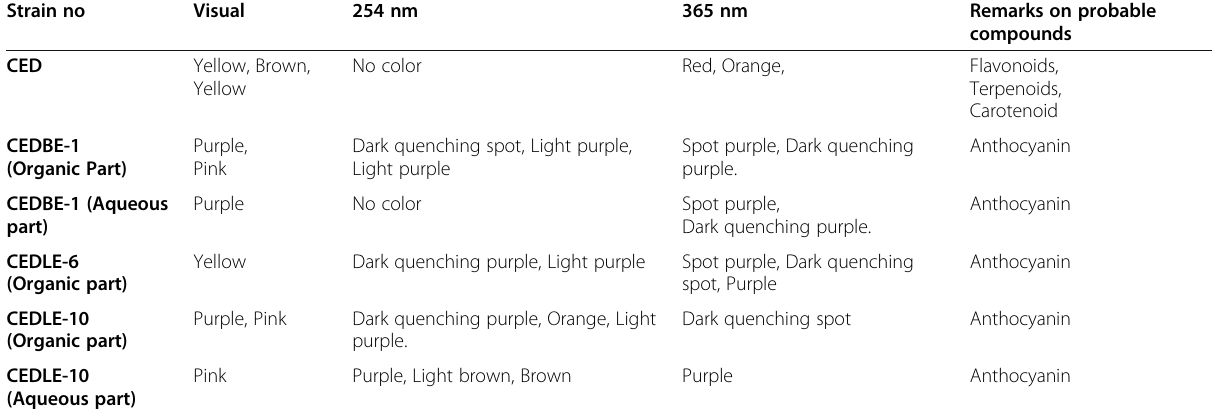
Table 3 Chemical screening of crude extracts of C. decandra and its associated fungi Strain